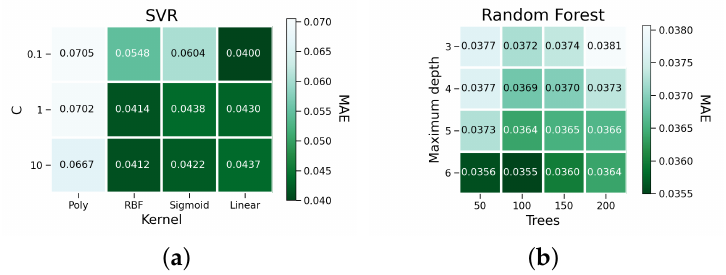
Figure 8. MAE grid search result for ( a ) SVR and ( b ) Random